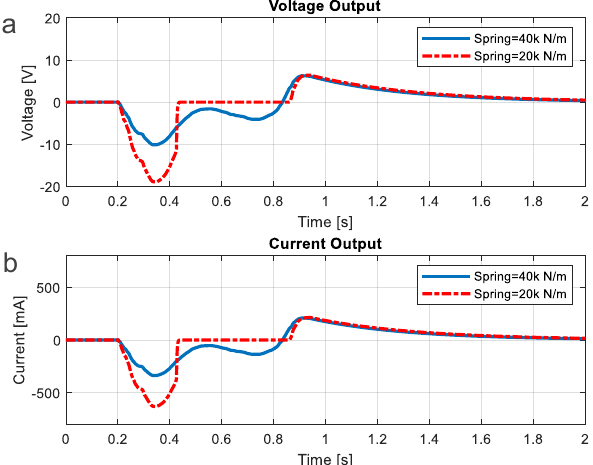
Figure 11. Simulation of Lead-Screw Model with Soft and Hard Springs. ( a ) Voltage of Lead-Screw Model with Soft and Hard Springs. ( b ) Current of Lead-Screw Model with Soft and Hard Springs.